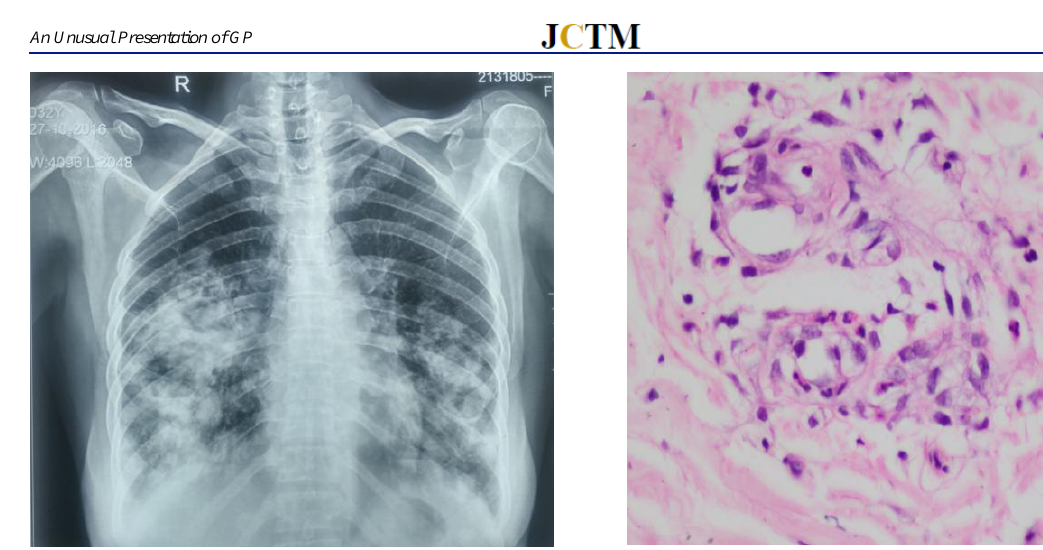
Figure 3 . H&E: 400X:Small vessel vasculitis seen in dermis. The vessel wall is infiltrated by neutrophils and few eosinophils for dengue virus and scrub typhus antibodies. In addition, the malaria rapid diagnostic test indicated no infection by Plasmodium vivax and falciparum . Albuminuria and microscopic hyperpigmented maculopapular dermal lesions were found on the dorsum of the right